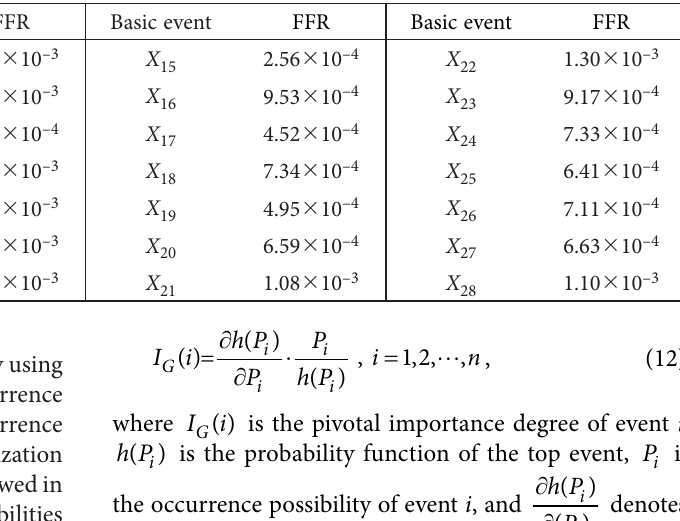
Table 5. FFRs of all basic events